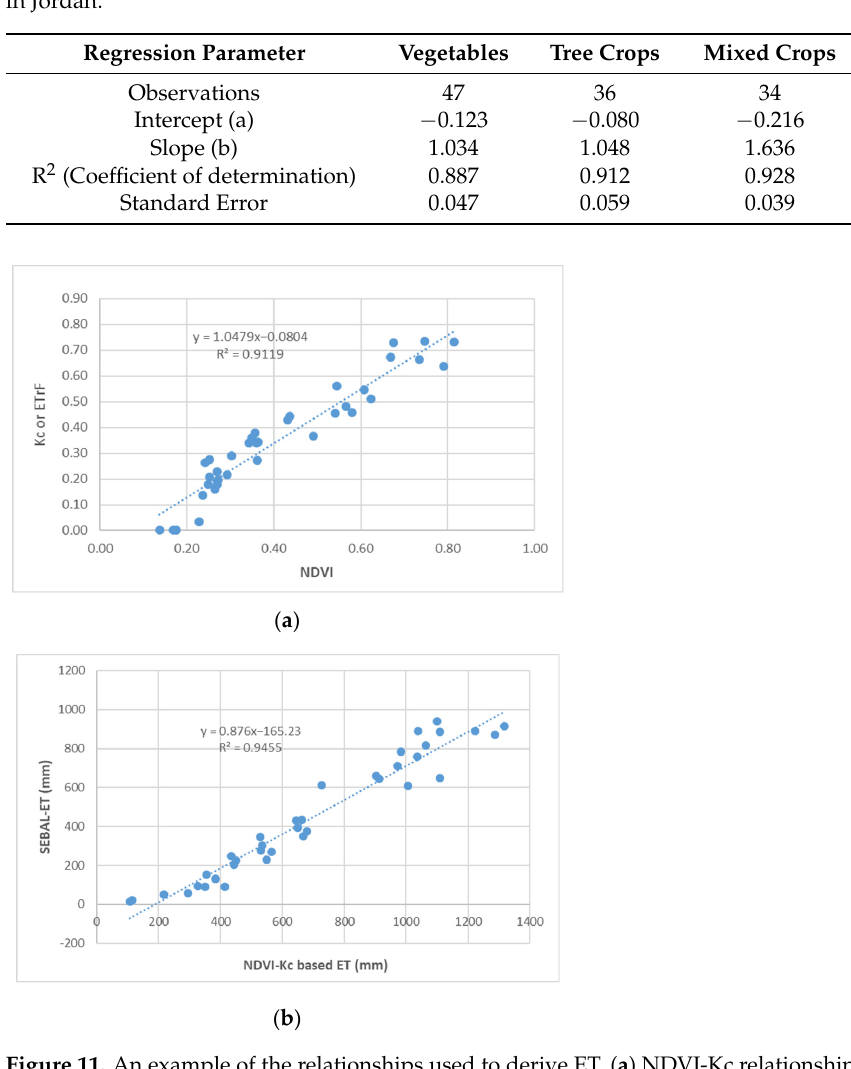
Figure 11. An example of the relationships used to derive ET. ( a ) NDVI-Kc relationship for vegetable crops; ( b ) NDVI-Kc-based ET vs. SEBAL-ET.